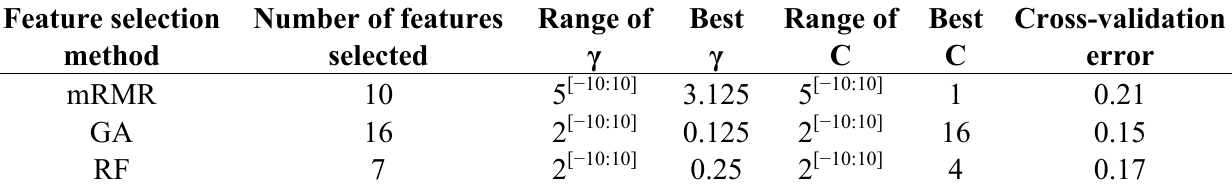
Table 2. Optimal parameters (C, γ ) for SVM approach.